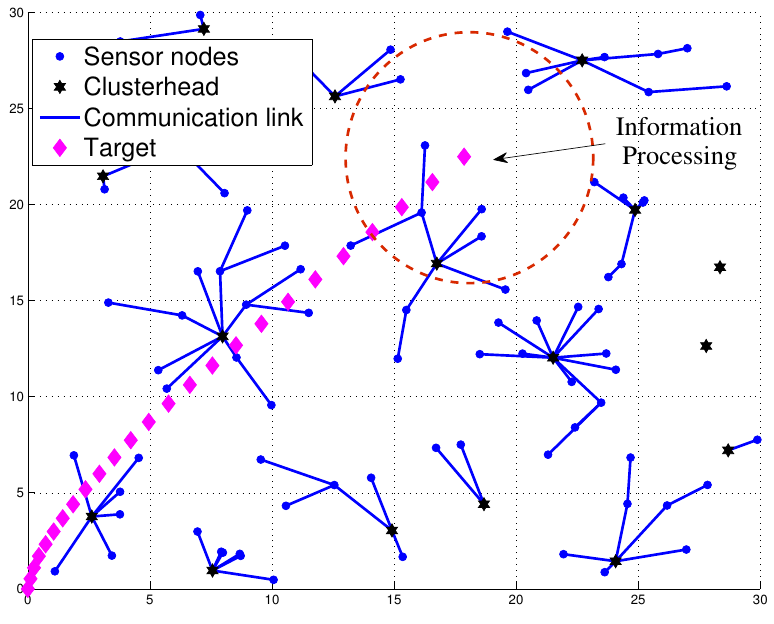
Figure 3. The cluster-based network topology and target movement with 25 time steps.